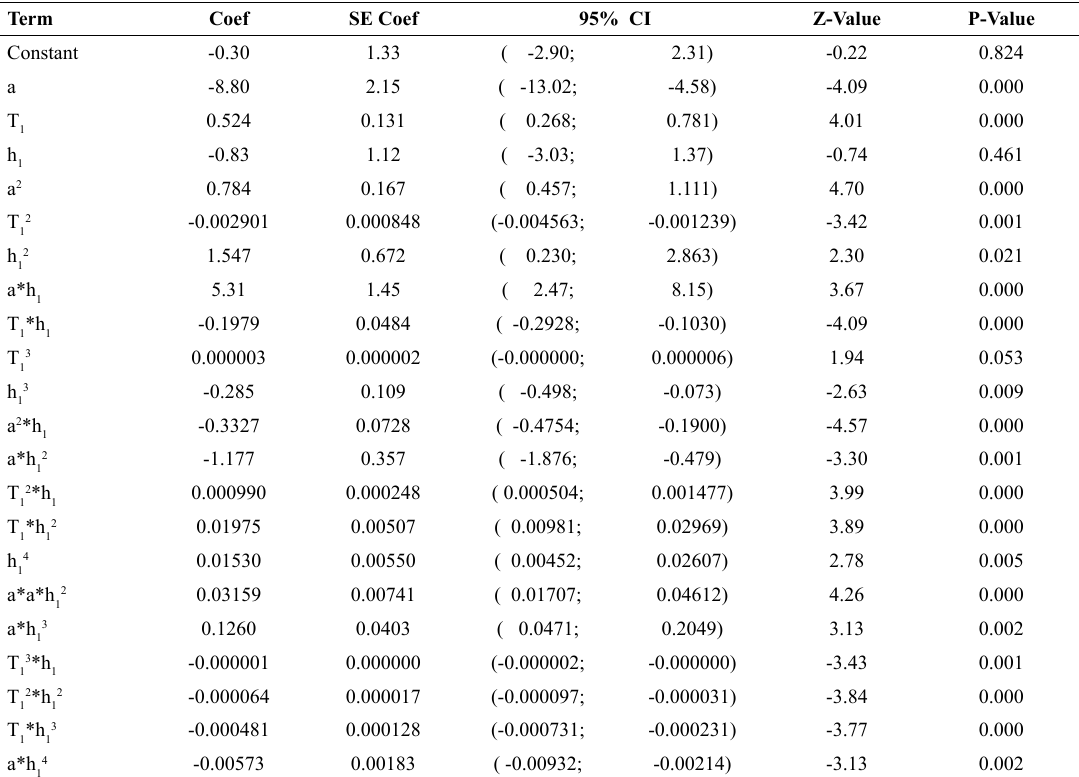
Table 9. Regression coefficients of tensile model with all factors.